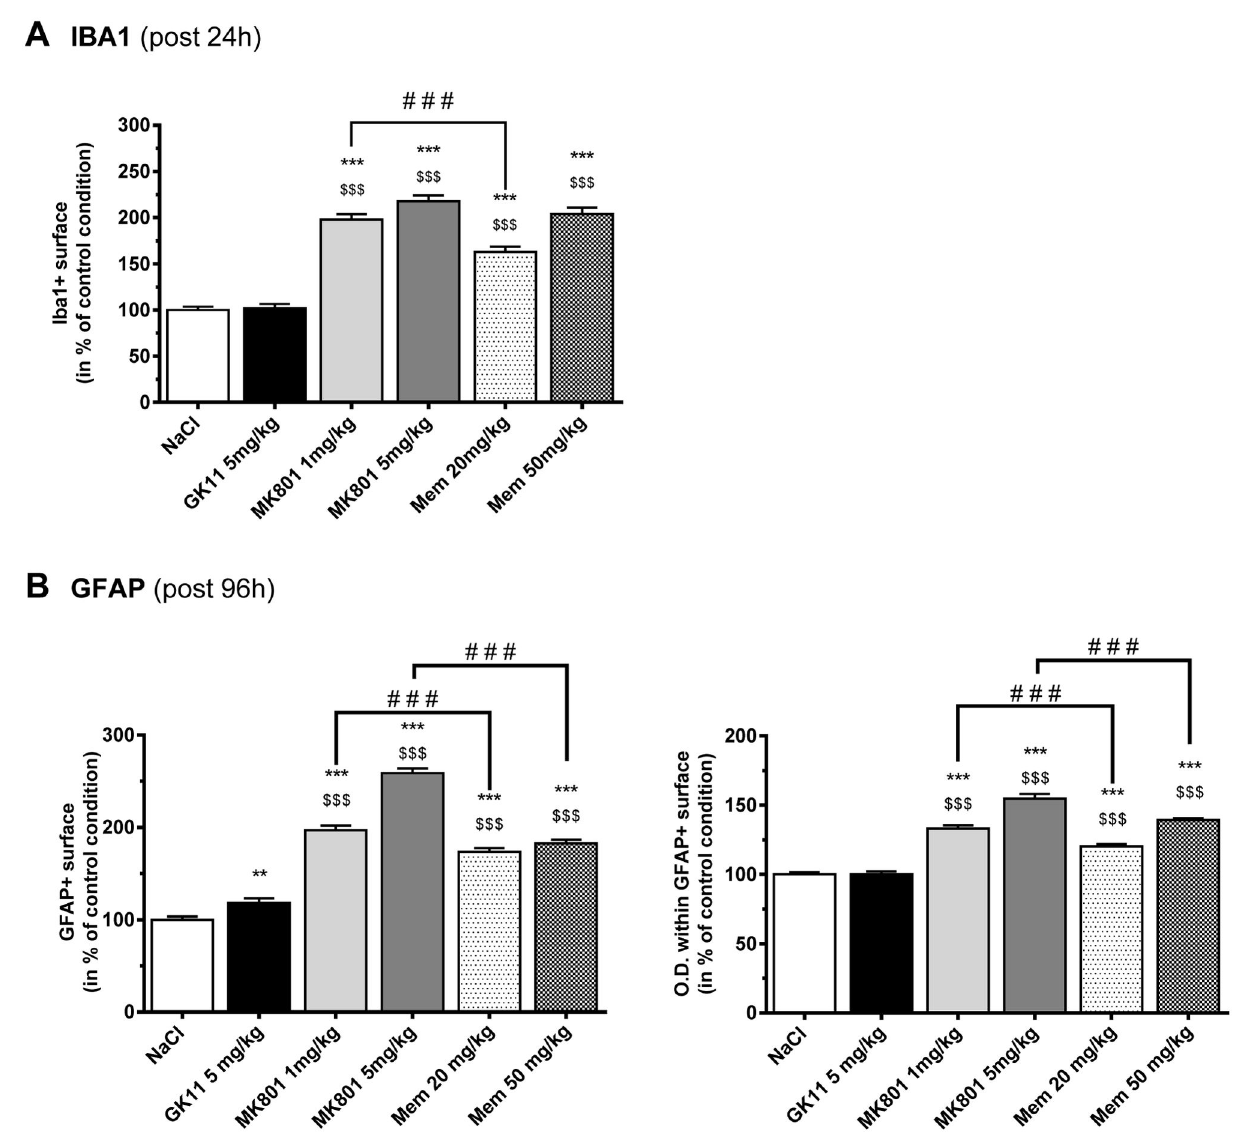
Figure 4. Effects of MK801, GK11 and Memantine treatment on glial and microglial activation in the rat cortex. ( A ) Quantitative analysis of the IBA1-labeled surface in the cingulate cortex 24h after the different drug treatments shows significant microglial activation after high and low doses of MK801 and Memantine treatment, but not after high-dose GK11 administration. The results are presented as the mean ± SEM (n=6 per group). ( B ) Quantitative analysis of the GFAP-labeled surface (left) and the Optical Density (right) within the labeled surface in the cingulate cortex (96h after the different drug treatments) shows significant astroglial activation after high and low doses of MK801 and Memantine treatment, but only a slight astrogliosis after high-dose GK11 administration. The results are presented as the mean ± SEM (n=3-6 per